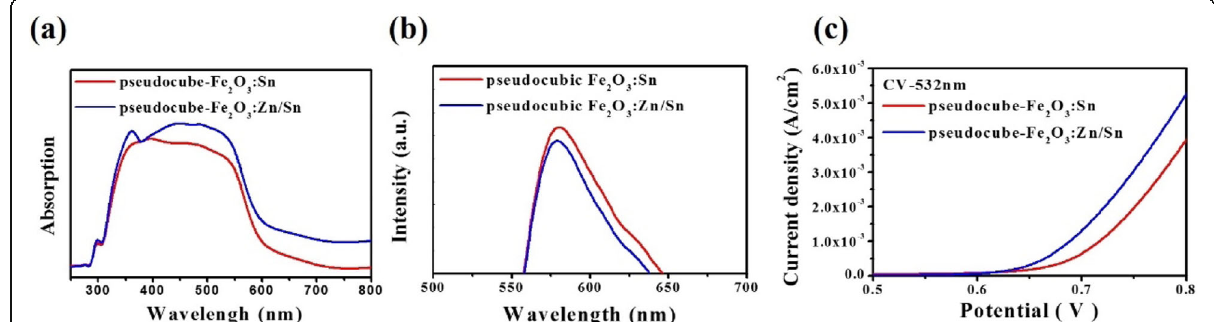
Fig. 5 a Absorption spectrum of the photoelectrodes of Fe 2 O 3 :Sn and Fe 2 O 3 :Zn/Sn; b PL analysis of the Fe 2 O 3 :Sn and Fe 2 O 3 :Zn/Sn photoelectrodes; and c J-V scans collected for different doped Fe 2 O 3